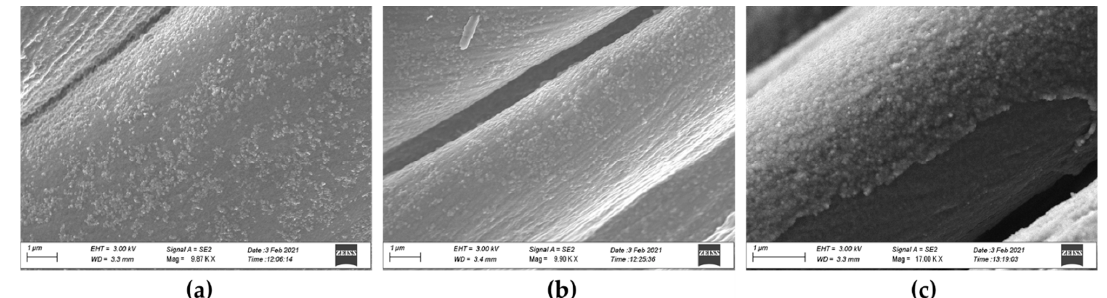
Figure 2. HR-SEM of PPy-coated cotton fabrics. ( a ) PPy-coated fabrics with PPy NPs before extraction in artificial sweat